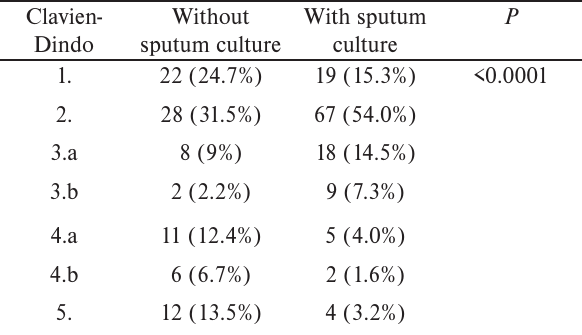
Table 2. Results of the patient set according to Clavien-Dindo classification of